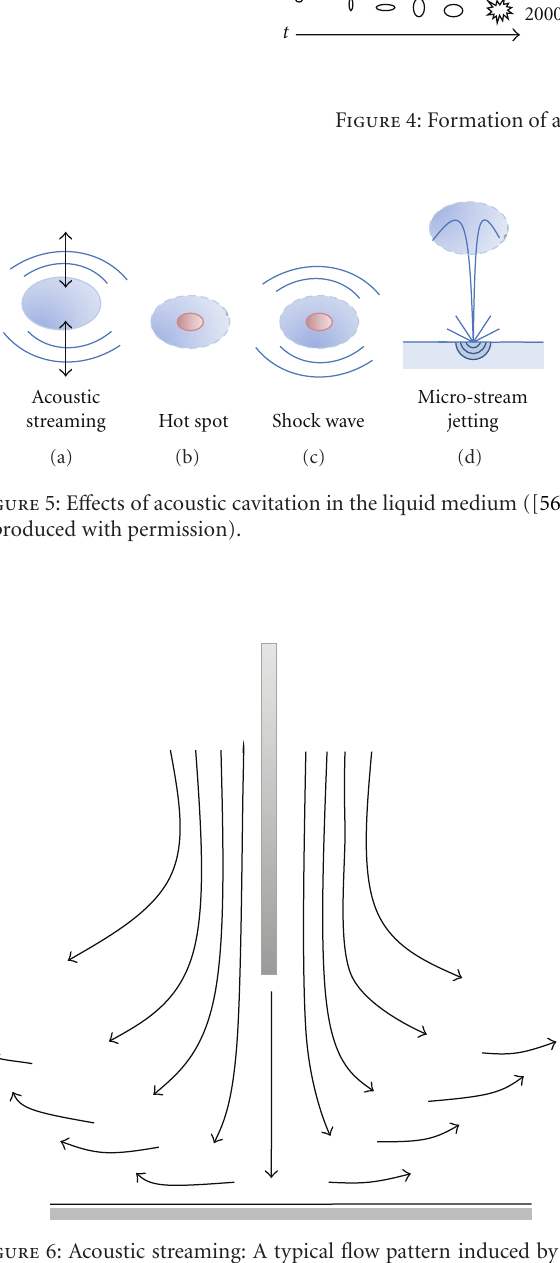
Figure 6: Acoustic streaming: A typical flow pattern induced by a sonic horn ([80], reproduced with permission).